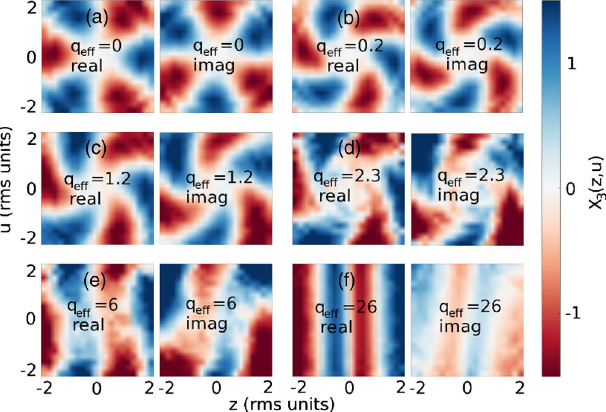
FIG. 4. 3D-G bunch. (a) – (f) The mode 3 longitudinal distri- bution, X 3 ð z; u Þ , for different values of the space charge param- eter q . Without space charge, X 3 ð z; u Þ ∝ e i 3 θ . With increasing eff q , X 3 ð z; u Þ transforms gradually to the third space charge eff harmonic [see Fig. 1 (c)]. At large q by a purely real